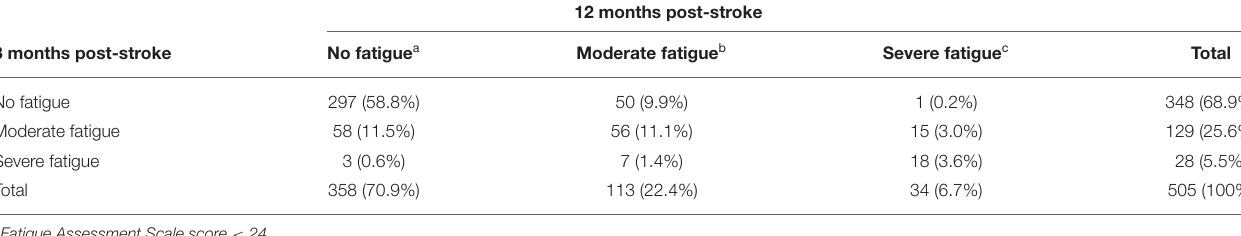
TABLE 3 | Frequency of fatigue 3 and 12 months post-stroke [ n